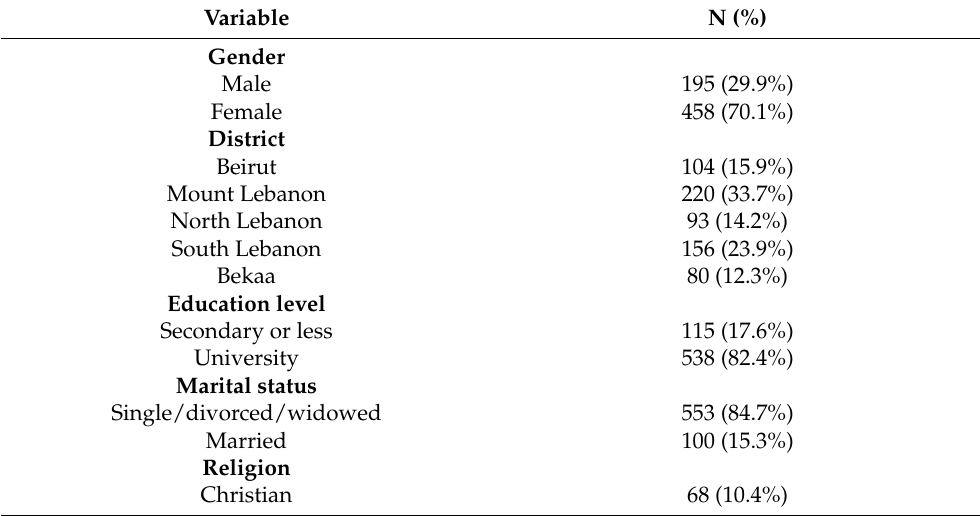
Table 1. Sociodemographic characteristics of the participants (N =